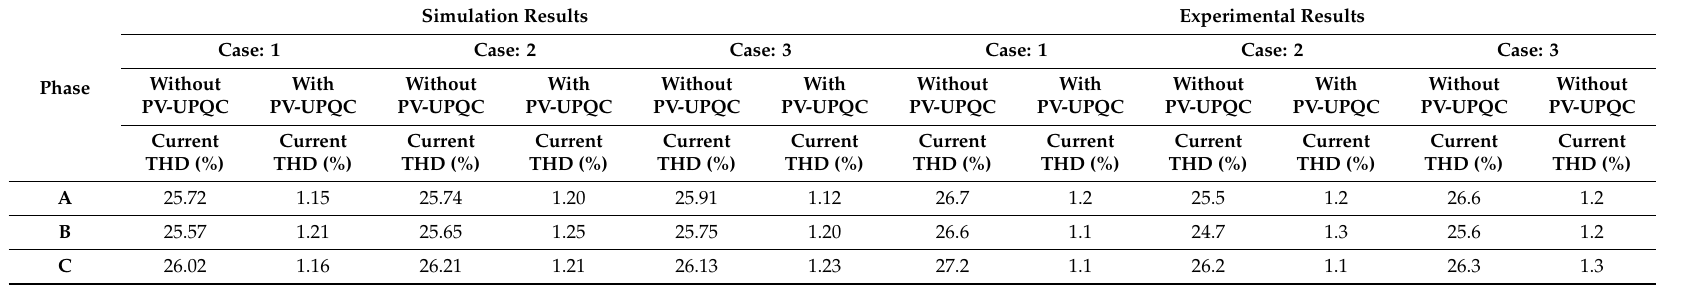
Table 2. Harmonic distortions with and without the QZSI-based solar photovoltaic-unified power quality